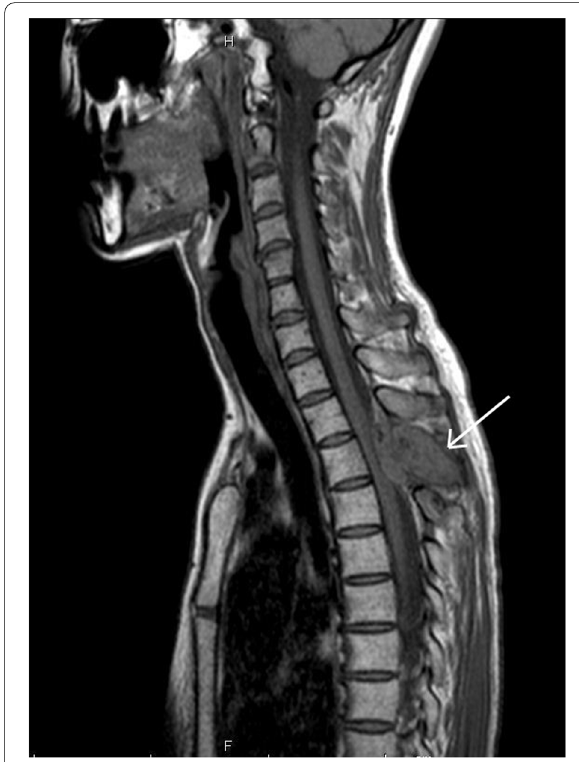
Fig. 1 Preoperative sagittal T1-weighted magnetic resonance imaging revealed a mass in the posterior portion of the third thoracic